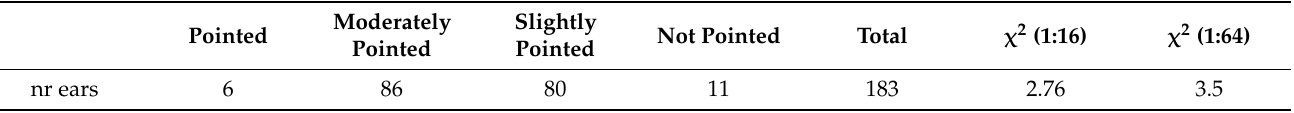
Figure 4. Inheritance of “pointed trait”. On the right is shown the cross between “Nero Spinoso” and “Rostrato Rosso di Rovetta”, given as an example of all the crosses carried out pairwise (complementation test) between the four pointed varieties. F1 hybrid (“Nero Spinoso” × “Rostrato Rosso di Rovetta”) remains pointed as does the whole of following F2 segregating population. On the left is shown the creation of an F2 population by crossing “Nero Spinoso” with B73/Mo17. The following F2 generation segregates for the “pointed trait”, permitting an estimation of the number of loci involved in this trait. Table 1. Segregation of the trait “pointed ears” in the F2 progeny obtained by crossing “Nero Spinoso” × B73/Mo17. The hypotheses made for the χ 2 test were 1:16 and 1:64 segregation values for “pointed ears”, considering two or three major genes, respectively, involved in the “pointed trait.